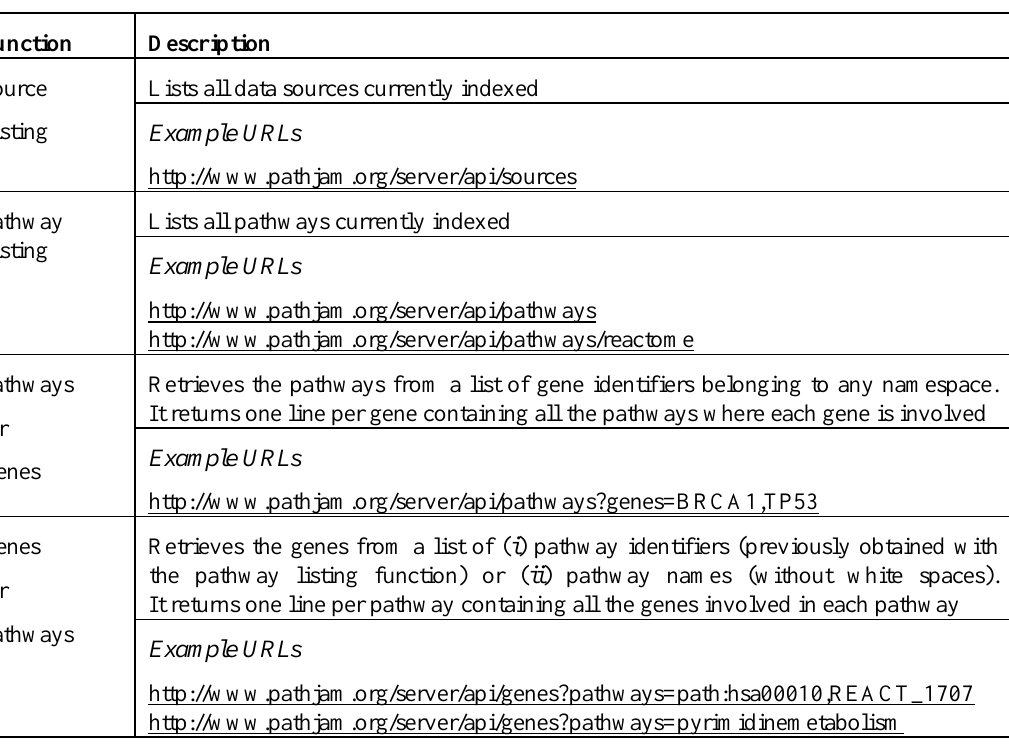
Table 4: Core functionality provided by PathJam RESTful